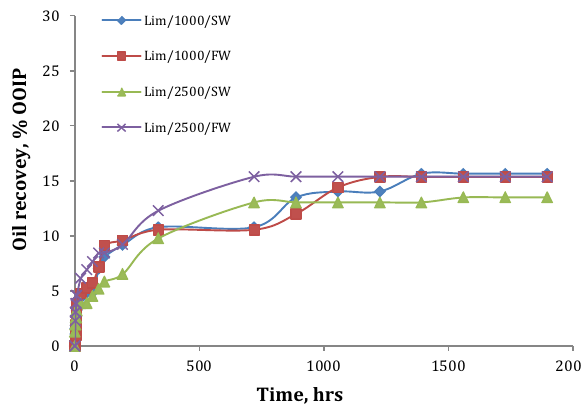
Fig. 4 Oil recovery from limestone samples aged for 1000 and 2500 h